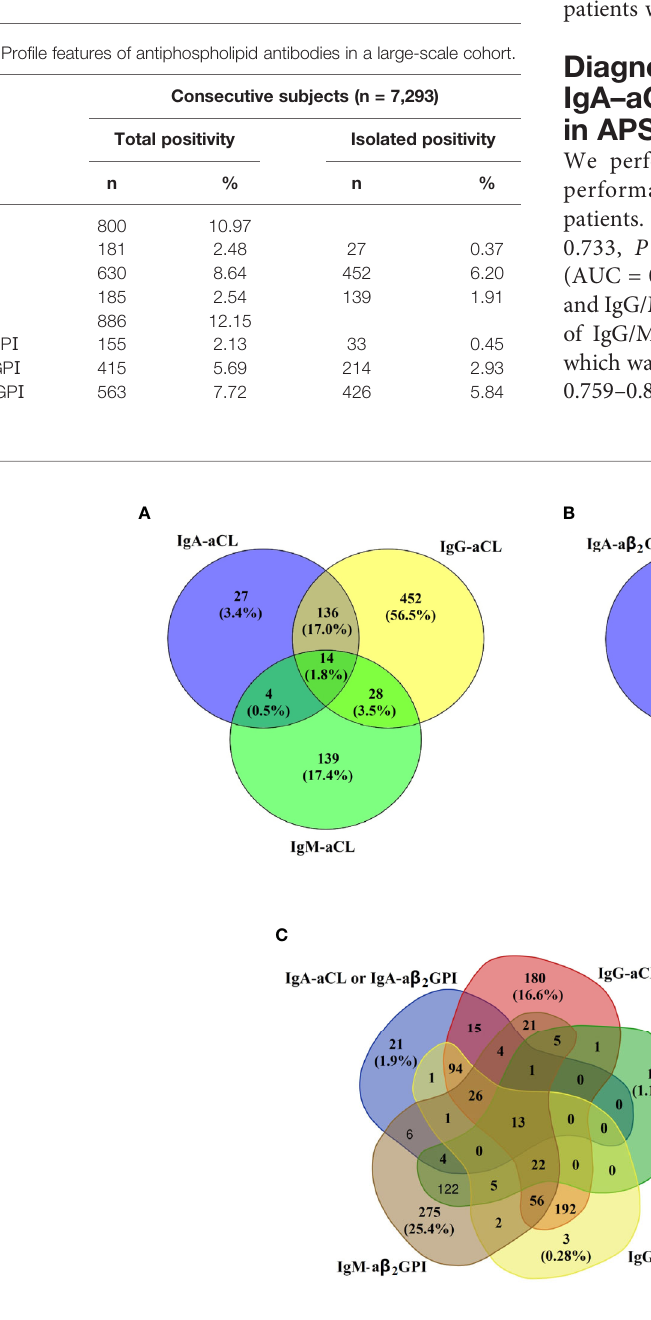
FIGURE 1 | Cross-positivity for (A) IgA – aCL, IgG – aCL, and IgM – aCL in 800 aCL-positive subjects; (B) IgA – a b 2 GP Ⅰ , IgG – a b 2 GP Ⅰ , and IgM – a b 2GPI in 886 a b 2 GP Ⅰ - positive subjects; and (C) IgA – aPL (either IgA – aCL or IgA – a b 2 GP Ⅰ was positive), IgG – aCL, IgM – aCL, IgG – a b 2 GP Ⅰ , and IgM – a b 2GPI in 1082 aPL-positive